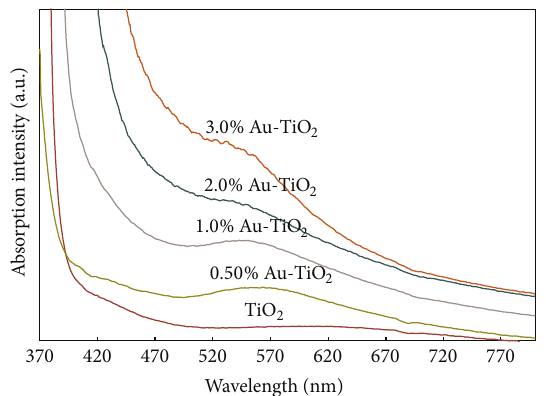
Figure 6: UV-vis absorption spectra of TiO 2 and 0.50–3.0 mol% Au-loaded TiO 2 films deposited on ITO substrate.